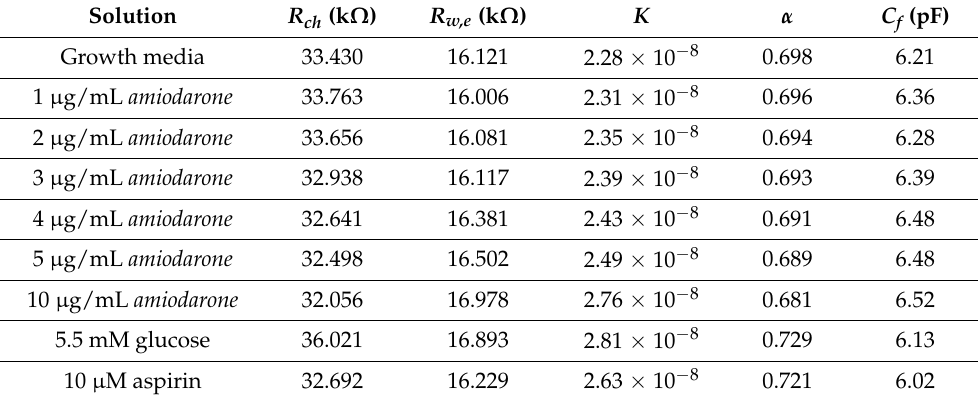
Table 1. Sample of extracted growth media (GM) and growth with drug parameters (GMD) based on curve-fitting to the impedance spectra at different drug